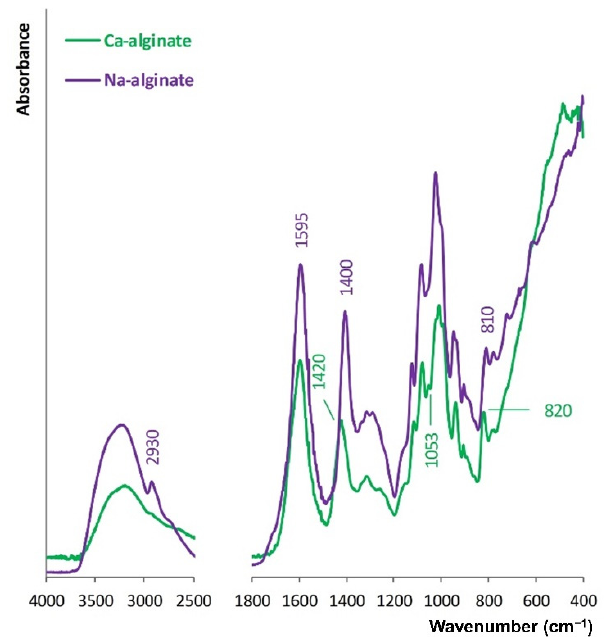
Figure 2. FT-IR spectra of the Na-alginate and the Ca-alginate. Absorbance bands attributed to stretching vibrations of O-H bonds for Ca-alginate are lower than for Na-alginate. This is due to the role of O-H and -COO- groups in the formation of a chelating structure with Ca 2+ ions. Accordingly, hydrogen bonding between O-H functional groups decreases. Moreover, the cations’ charge density, radius, and atomic weight change when Ca 2+ ions replace Na + ions. Hence, this shifting of the C-O absorbance bands from 1400 to 1420 cm − 1 occurs, C-O stretching vibration absorption increases, and an absorbance band at 1053 cm − 1 appears [39]. Na-alginate has an absorption band at 2930 cm − 1 that is assigned to the stretching vibration of C-H in the six-membered ring, which cannot be observed in the spectrum of Ca-alginate. Crosslinking with Ca 2+ ions promoted the formation of the egg-box model. Thus, the stretching vibration of C-H in the six-membered ring of the Ca-alginate molecule is limited [40].